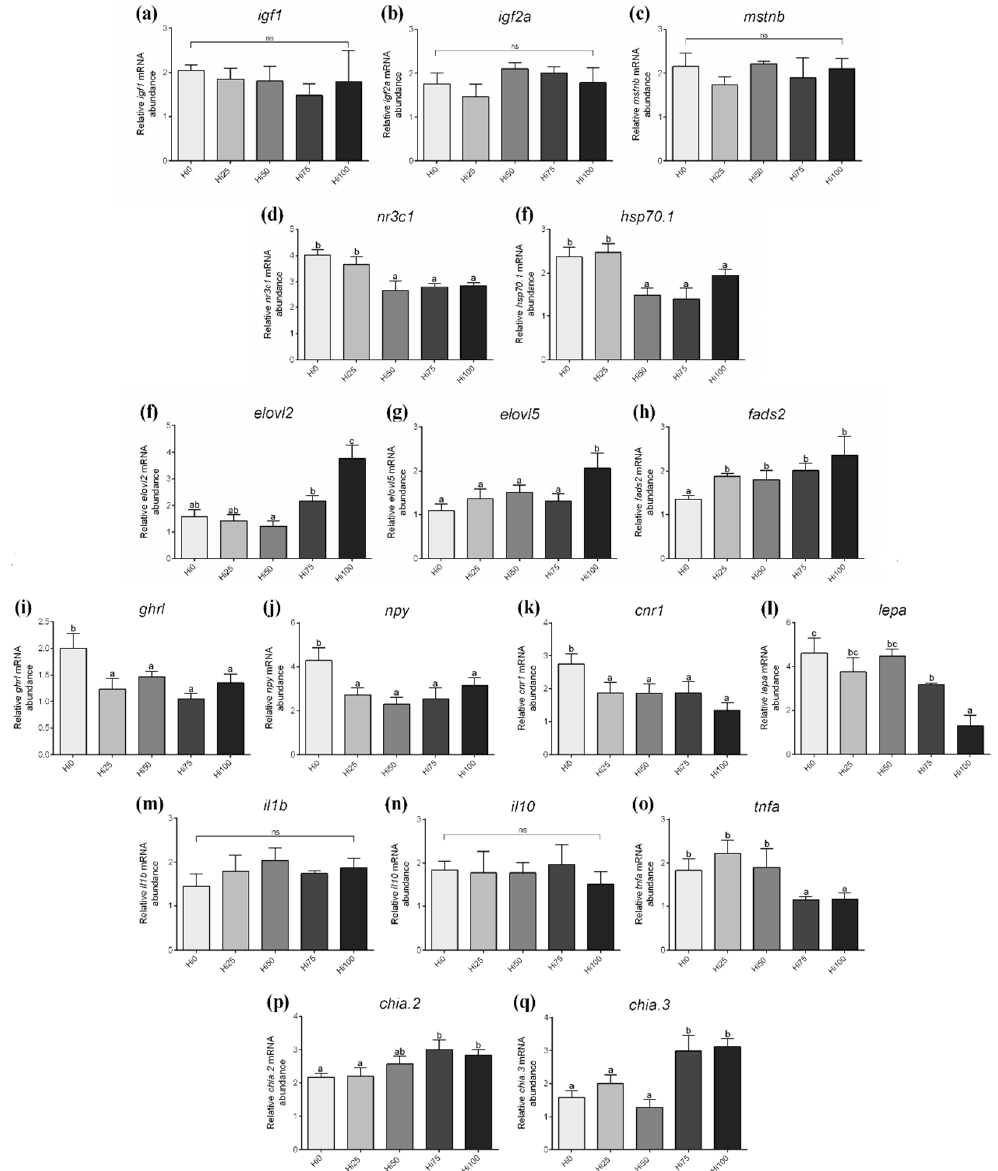
Figure 5. Relative mRNA abundance of genes analyzed in F1 zebrafish larvae fed diets including 0%, 25%, 50%, 75% and 100% of BSF prepupae meal respect to FM (F1Hi0, F1Hi25, F1Hi50, F1Hi75 and F1Hi100 groups). ( a ) igf1 , ( b ) igf2a , ( c ) mstnb , ( d ) nr3c1 , ( e ) hsp70.1 , ( f ) elovl2 , ( g ) elovl5 , ( h ) fads2 , ( i ) ghrl , ( j ) npy , ( k ) cnr1 , ( l ) lepa , ( m ) il1b , ( n ) il10 , ( o ) tnfa , ( p ) chia.2 and ( q ) chia.3 . a–c Different letters specify statistically significant differences among experimental groups ( p < 0.05). Values are shown as mean ± standard deviation ( n = 5). ns: no significant differences.